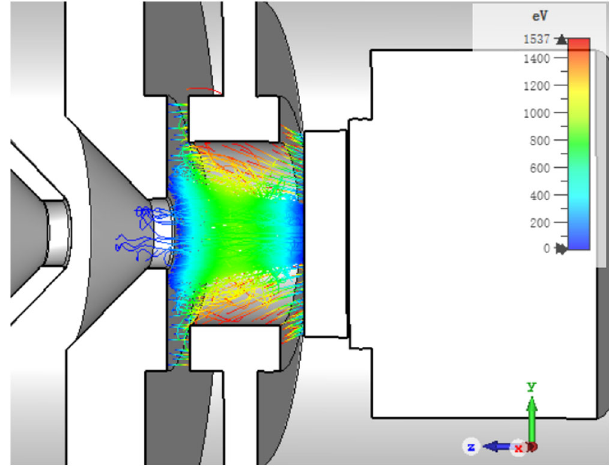
FIG. 4. The optimized magnetic field simulation result of the Penning ion source.